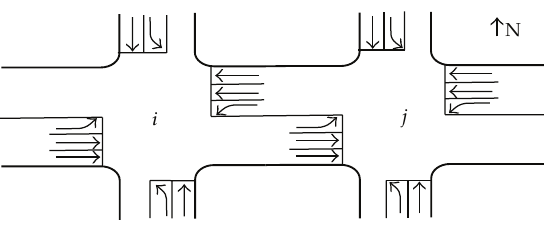
Figure 5: Simulation testing arterial schematic.